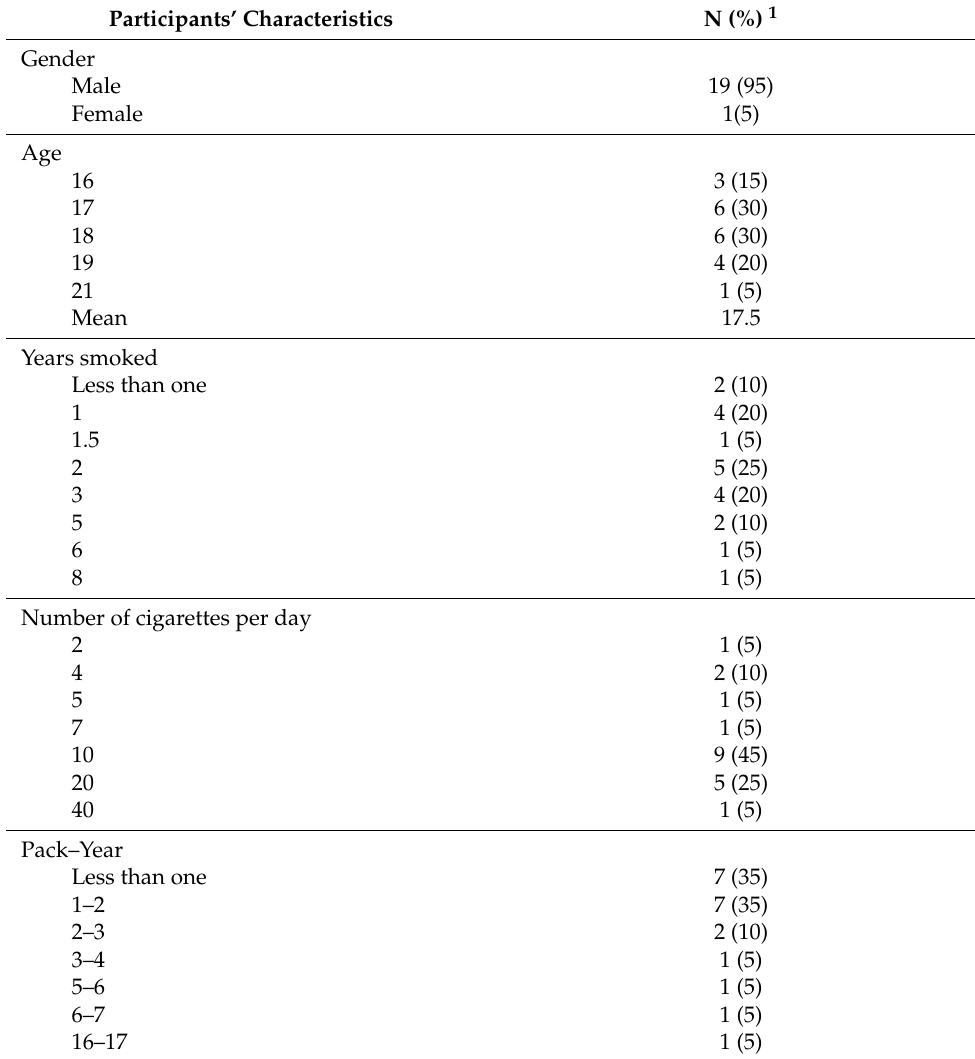
Table 1. Demographic characteristics of participants. Participants’ Characteristics N (%)